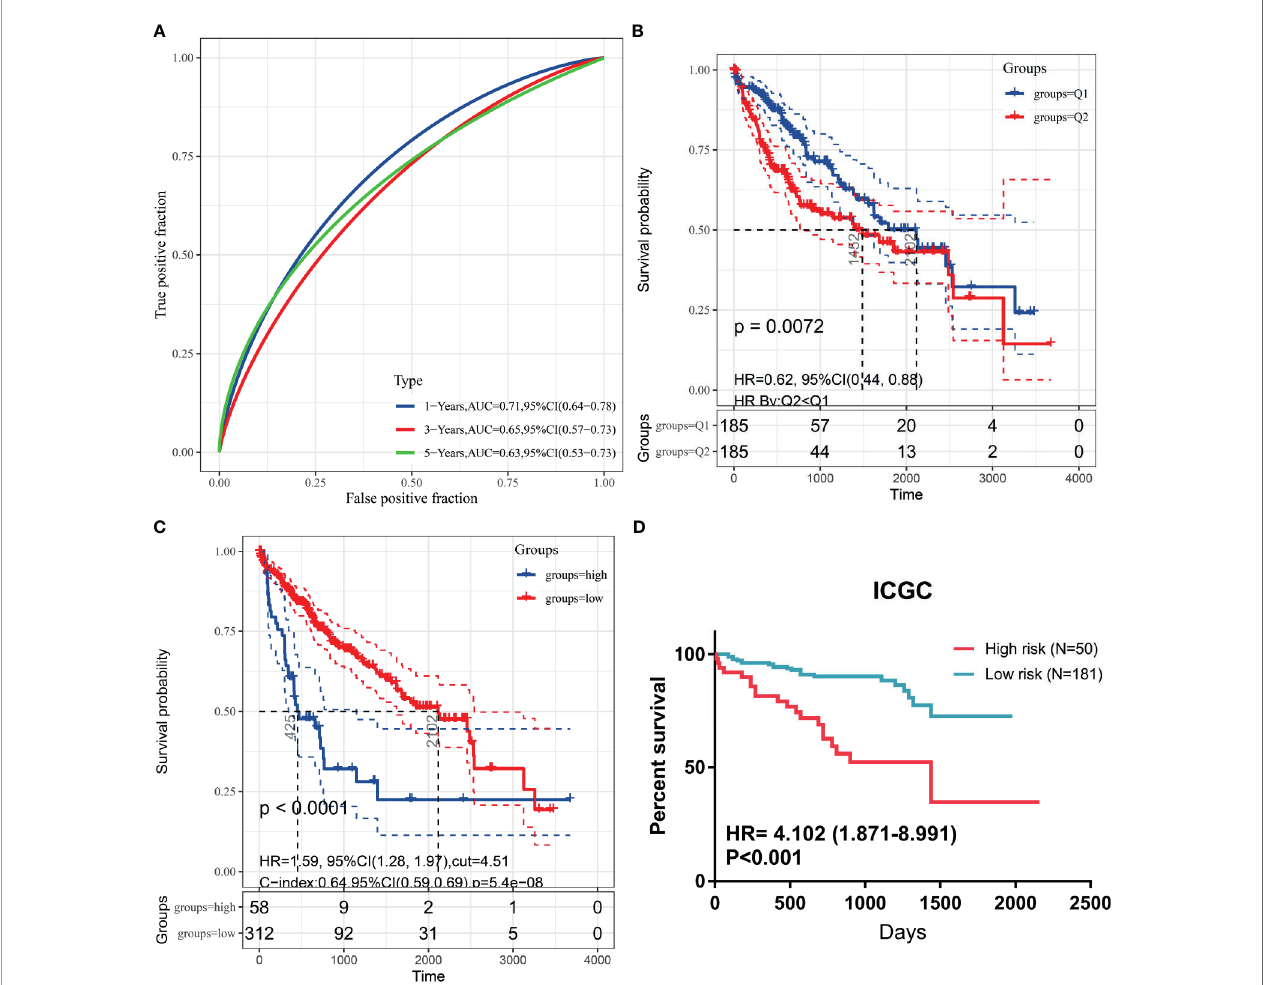
FIGURE 6 | Kaplan-Meier plots for DDR signature cut-off identi fi cation. (A) Time-dependent ROC for DDR signature survival prediction in TCGA database; (B) survival difference between high and low DDR signature based on median value; (C) survival difference between high and low DDR signature based on best separation in training cohort; (D) cut-off from TCGA cohort could be useful for risk strati fi cation in ICGC